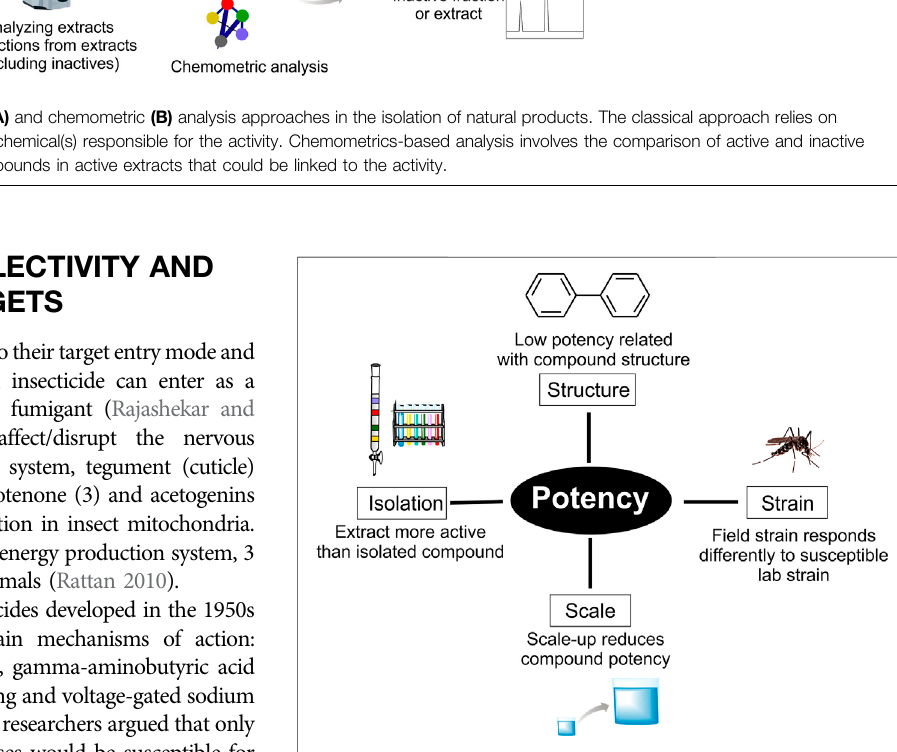
FIGURE 3 | Common problems associated with the low potency of natural